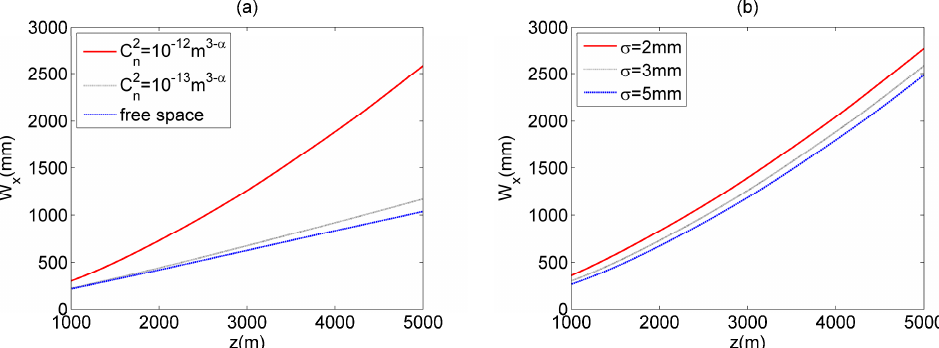
W of N D × MGSM array beams with 3 N D = = propagating through non- Figure 6. The Figure 6. The W x of N × D MGSM array beams with N = D = 3 propagating through non- Kolmogorov x C and ( b ) different σ . turbulent atmosphere. ( a ) di ff erent C 2 n and ( b ) di ff erent σ Kolmogorov turbulent atmosphere. ( a ) different 2 n